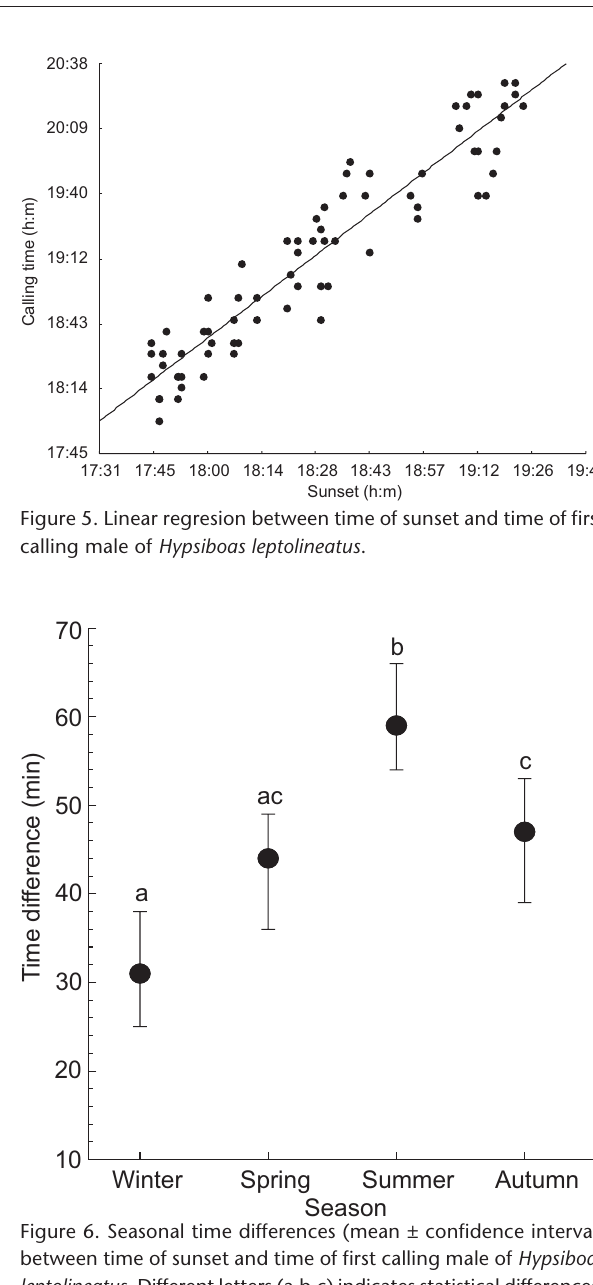
Figure 6. Seasonal time differences (mean ± confidence interval) between time of sunset and time of first calling male of Hypsiboas leptolineatus . Different letters (a,b,c) indicates statistical differences, based on Tukey’s comparison of means test.